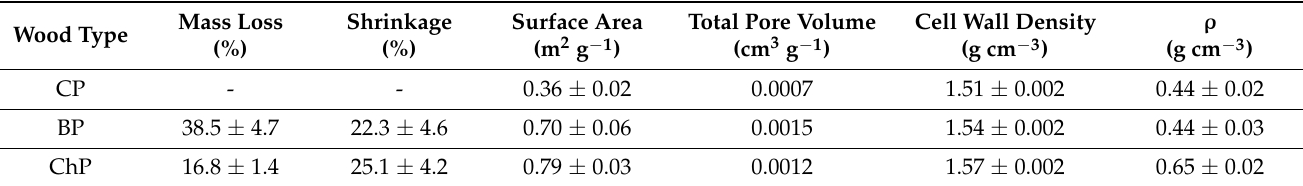
Table 1. Average values of mass loss, shrinkage, surface area, total pore volume, cell wall density and bulk density ( ρ ) for sound/undegraded (CP), biologically (BP) and chemically (ChP) degraded pine